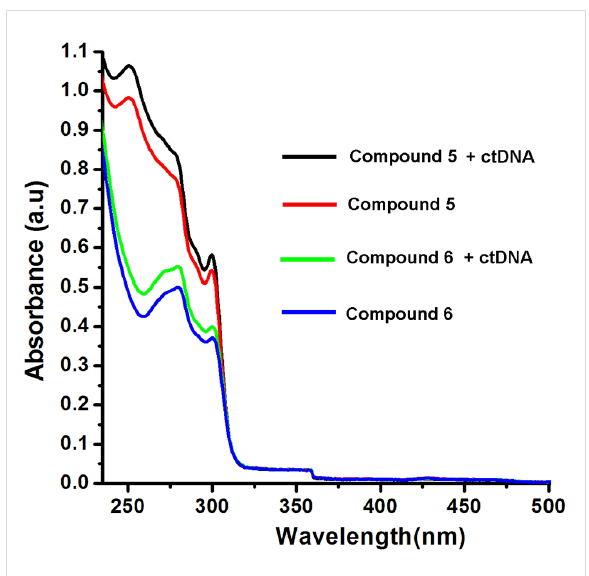
Figure 4: UV–vis spectra showing the hyperchromic effect after addi- tion of ctDNA (20 μ M) to 5 and 6 (80 μ M).